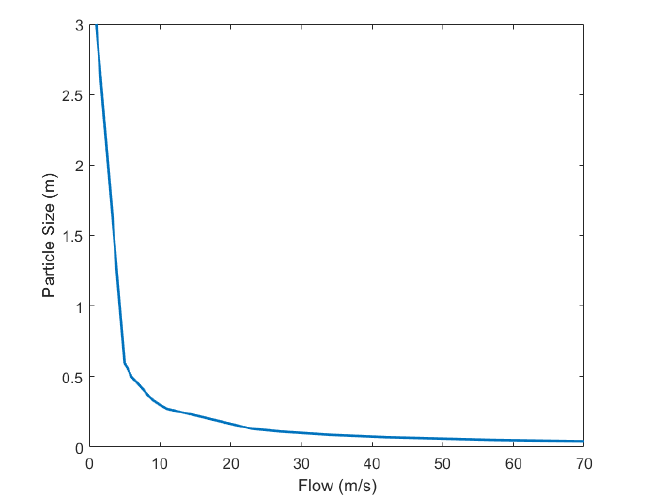
Figure 9. An example of how the particle size of species influences the flow as part of the ratio control